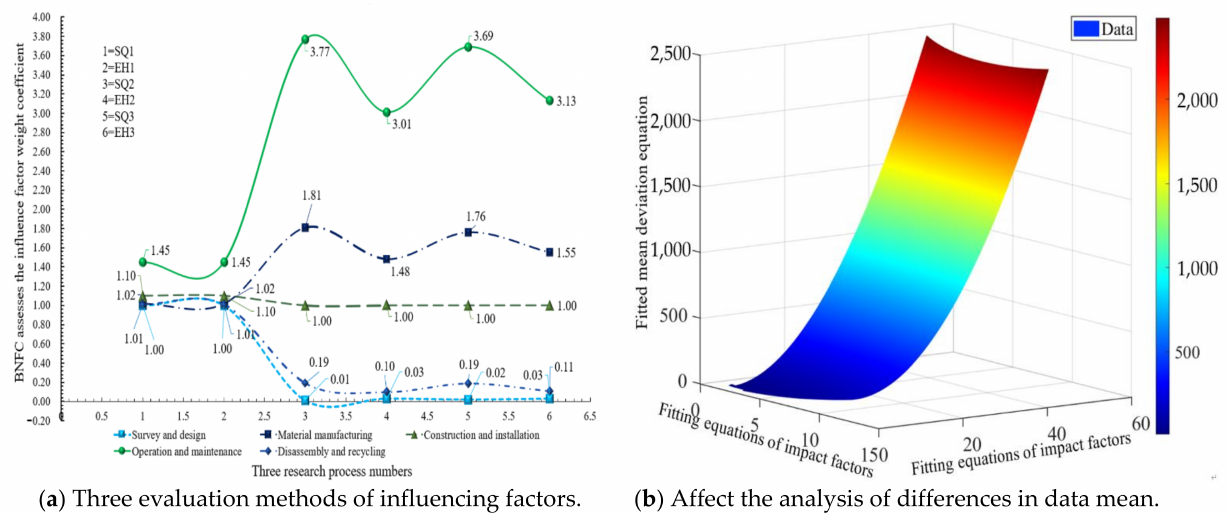
Figure 11. The influencing factors obtained by the three evaluation methods are compared and fitted with the analysis of mean